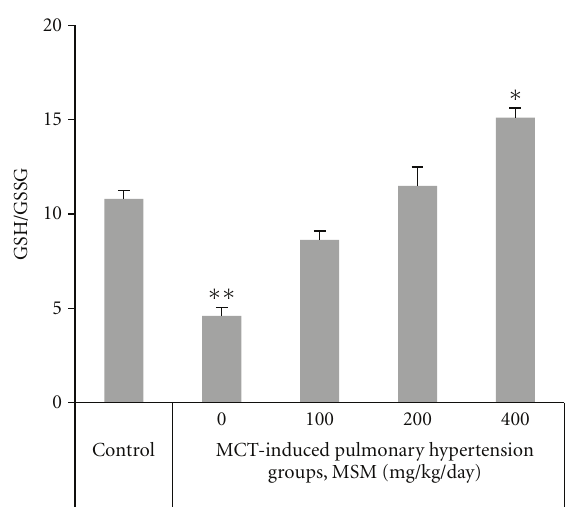
Figure 2: E ff ects of di ff erent doses (0–400 mg/kg/day) of methyl- sulfonylmethane (MSM) on lipid peroxidation expressed as the contents of malondialdehyde (MDA) in rats with monocrotaline- (MCT-) induced pulmonary hypertension (regression coe ffi cient r 2 = 0 . 44, P < 0 . 01). Data are means ± SE, n = 6. Significant Tukey’s post hoc di ff erences compared with controls are indicated by asterisks ( ∗∗ P < 0 . 01 and ∗ P < 0 .